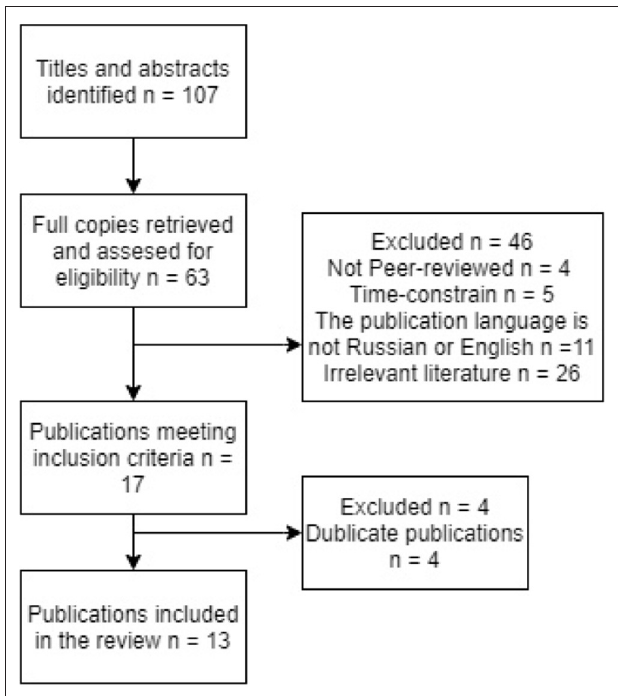
FIGURE 1 | Flow chart